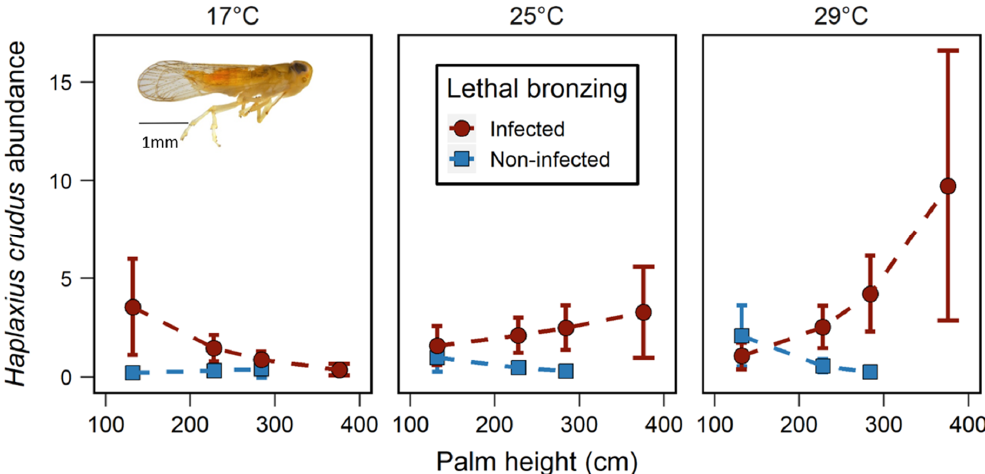
Figure 3. Mean ± SE of Haplaxius crudus abundance on lethal bronzing-infected and non-infected palms at different temperatures and palm heights. Dots are estimated marginal means at the lowest (132 cm), the median (228 cm), and the highest (284 cm for non-infected and 376 cm for lethal bronzing-infected palms) tree height.